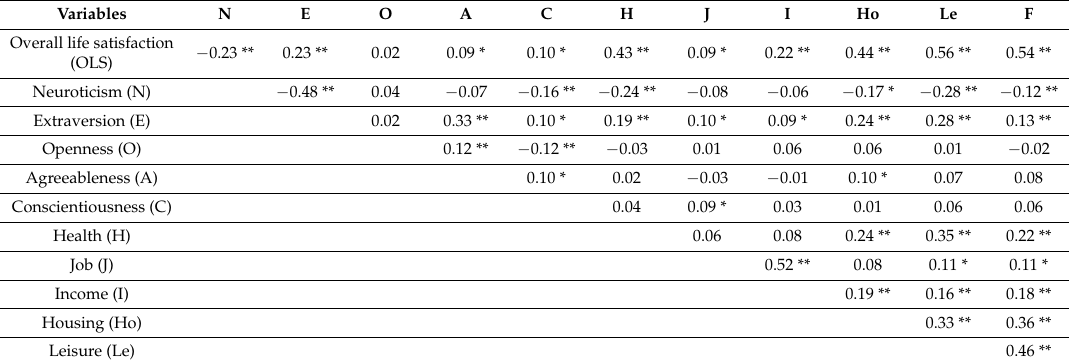
Table 8. Correlations of personality (NEO-FFI) and satisfaction variables for Survey 3. ( N = 496). Variables N